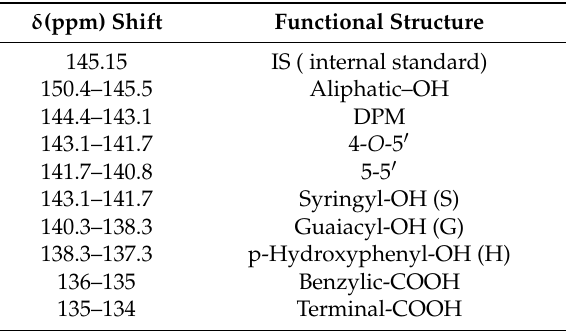
Table 7. Chemical shifts of various lignin functional groups [37].